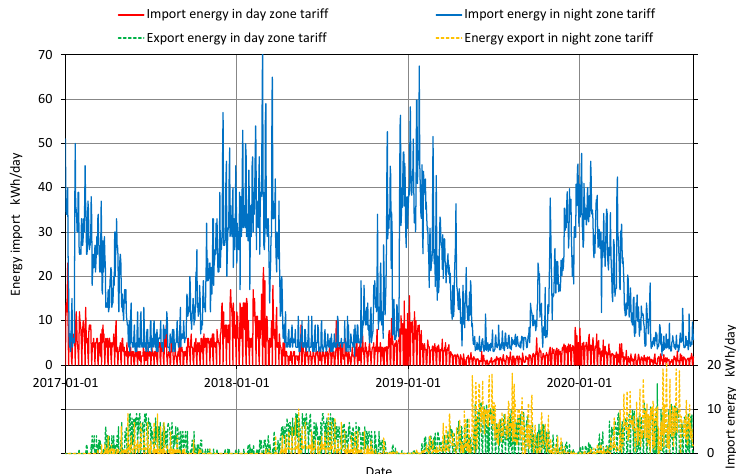
Figure 9. Over three years of data collection of energy import and export.